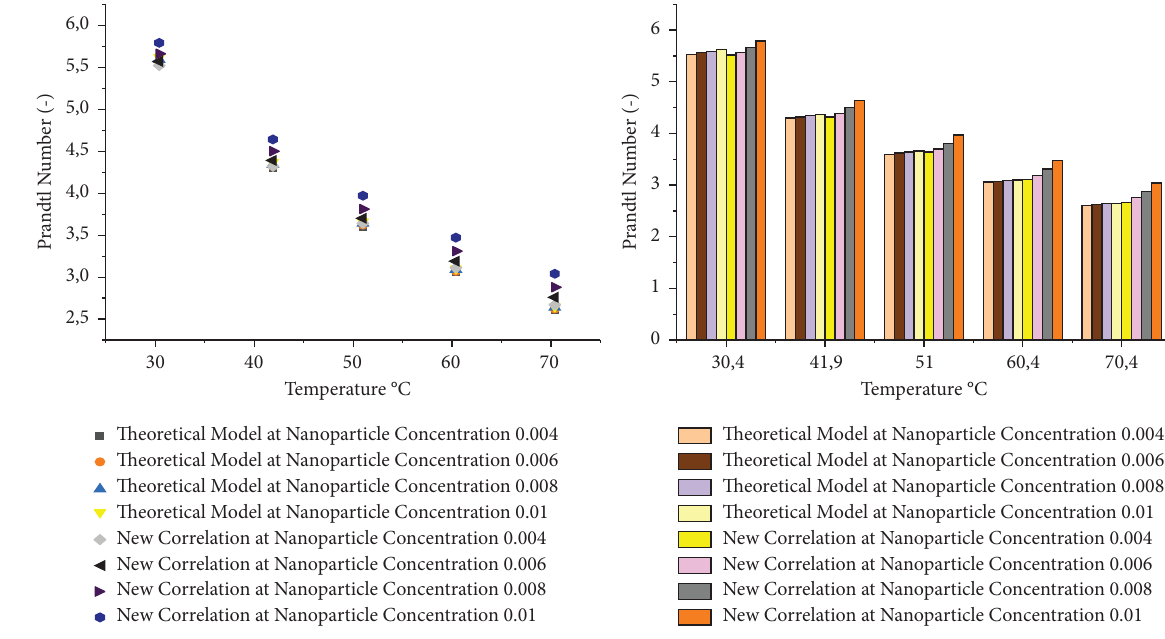
Figure 6: Comparison of titanium oxide-water nanofuid Prandtl number theoretical model and new